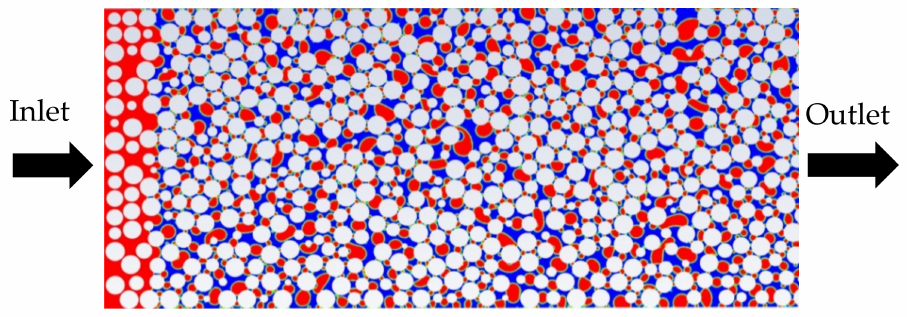
Figure 1. The geometry of the computational domain (50% water